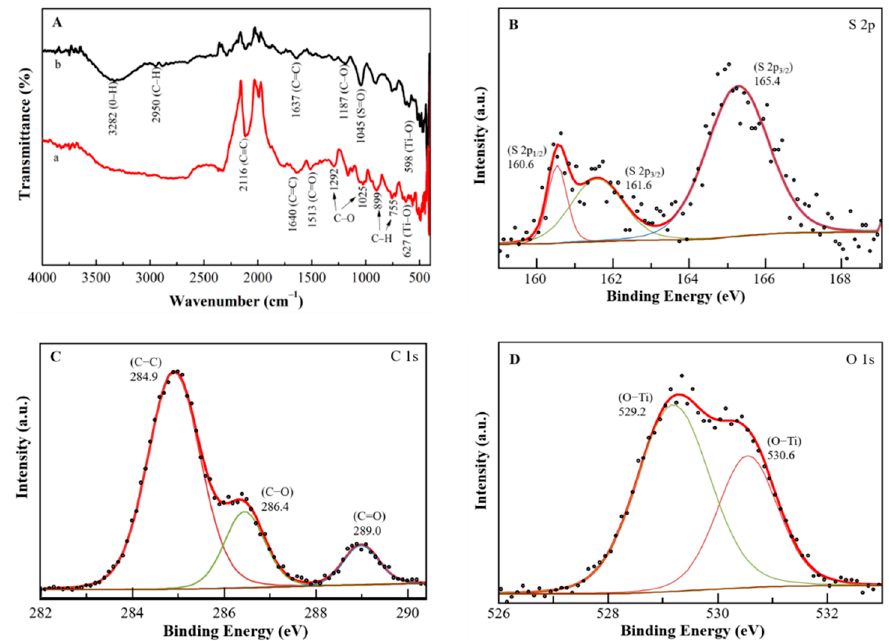
Figure 2. ( A ) FTIR spectrum of (a) PEDOT:PSS/Ti 3 C 2 /GQD and (b) PEDOT:PSS/Ti 3 C 2 /GQD in presence of GOx immobilization. XPS spectrum and high-resolution XPS spectra of ( B ) S 2p, ( C ) C 1s and ( D ) O 1s of the PEDOT:PSS/Ti 3 C 2 /GQD − GOx.